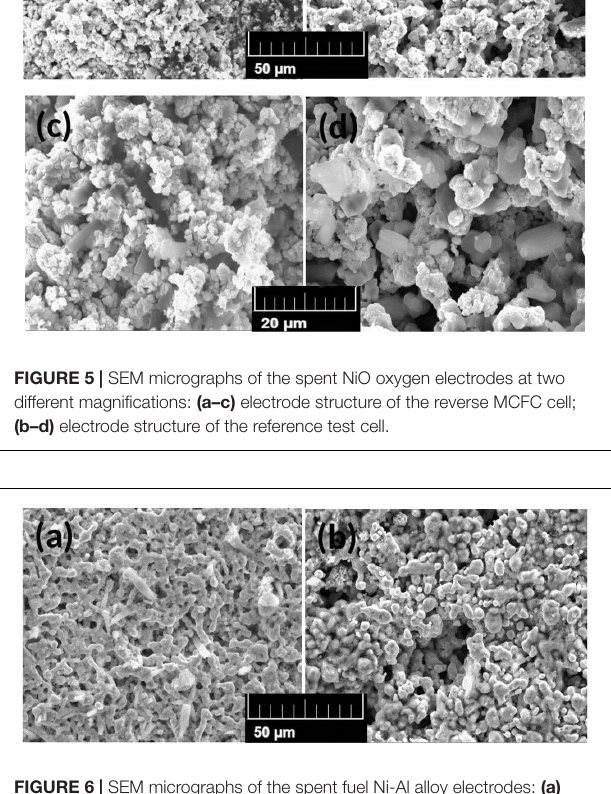
FIGURE 6 | SEM micrographs of the spent fuel Ni-Al alloy electrodes: (a) electrode structure of the reverse MCFC cell; (b) electrode structure of the reference test cell.